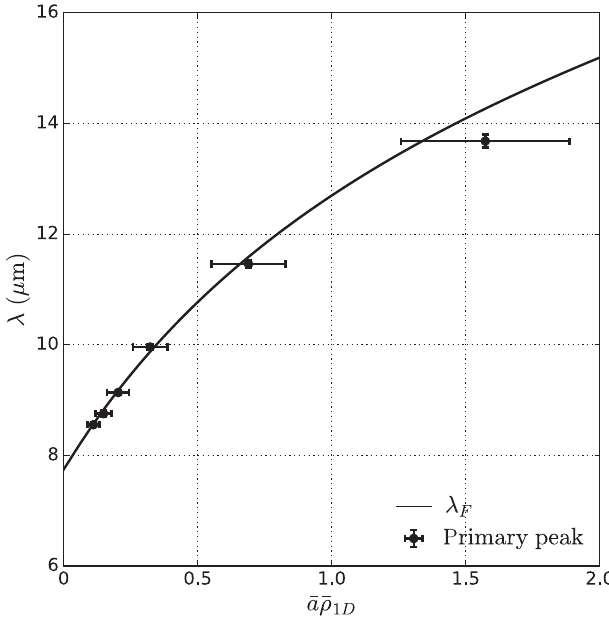
FIG. 4. Interaction dependence of λ . The relevant interaction F parameter is ¯ a ¯ ρ , where ¯ ρ is the average line density and ¯ a varies between 1 a 0 and 26 a 0 . Here, Δ B ¼ 5 G, corresponding to Δ a ¼ ¯ a ¼ 1 a ¯ a ¼ 26 a 0 . 7 a Δ a ¼ 3 a 0 for 0 and 0 for 0 . The data are indicated by filled squares, while the solid line is the theory of Ref. [15]. The error bars along the vertical axis correspond to the standard error, determined from ten different experimental runs, while the error bars along the horizontal axis arise from the systematic uncertainty in determining ¯ a [30].